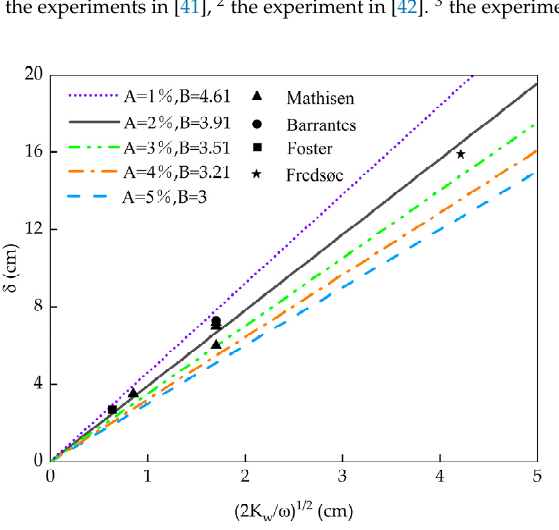
Figure 4. δ as a function of (cid:3493) 2 K w ω ⁄ .